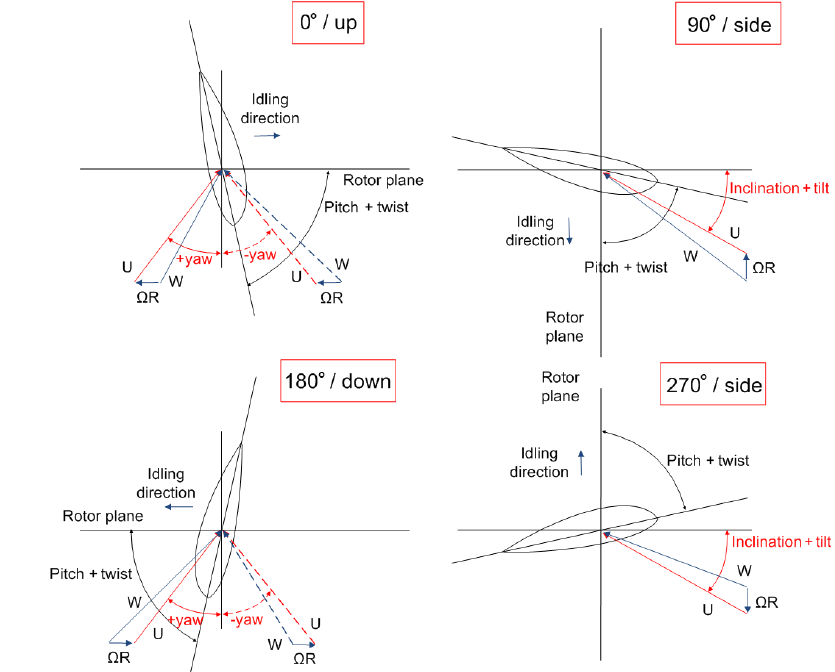
Figure 5. Velocity triangles of an idling blade at different azimuth positions.